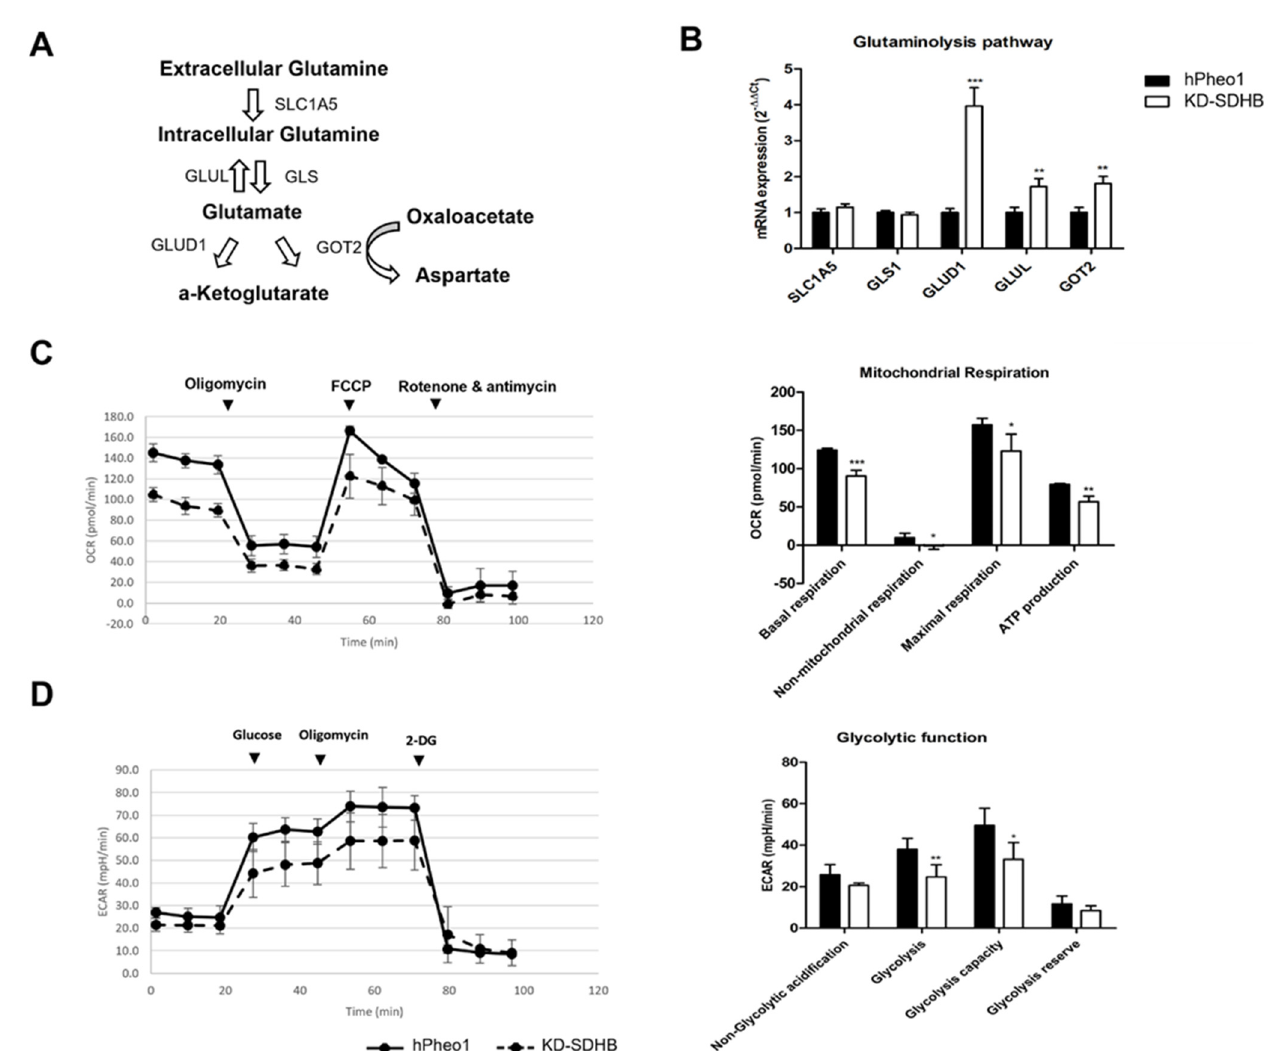
Figure 6. ( A ) Summary indicating the glutaminolysis pathway. ( B ) Upregulation of the gene set of glutaminolysis by knocking down SDHB. Each bar represents the mean ± standard deviation, ** ( p < 0.001) and *** ( p < 0.0001), student’s t ‐ test. ( C ) The Agilent Seahorse XF24 analysis of mitochondrial function shows an alteration in OCR in KD ‐ SDHB cells compared to acute disruption of ATP ‐ linked oxygen hPheo1 cells cultured in deprived media of glutamine. Basal respiration, non ‐ mitochondrial oxygen consumption, maximal respiration, and ATP production were calculated according to manufacturer’s protocol. Student’s t ‐ test p values indicated as * ( p < 0.01), ** ( p < 0.001) and *** ( p < 0.0001). ( D ) The Agilent Seahorse XF24 analysis of glycolytic function shows an alteration in the ECAR in KD ‐ SDHB cells compared to hPheo1 cells cultured in deprived media of glutamine. Specific parameters for non ‐ glycolytic acidification, glycolysis, glycolytic capacity, and glycolytic reserve were calculated according to manufacturer’s protocol. Student’s T ‐ test p values indicated as * ( p < 0.01) and ** ( p < 0.001).